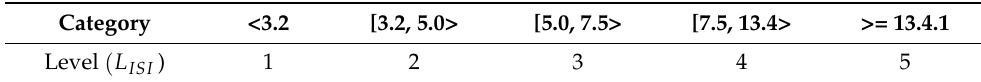
Table 2. Initial Spread Index (ISI) categories [47].